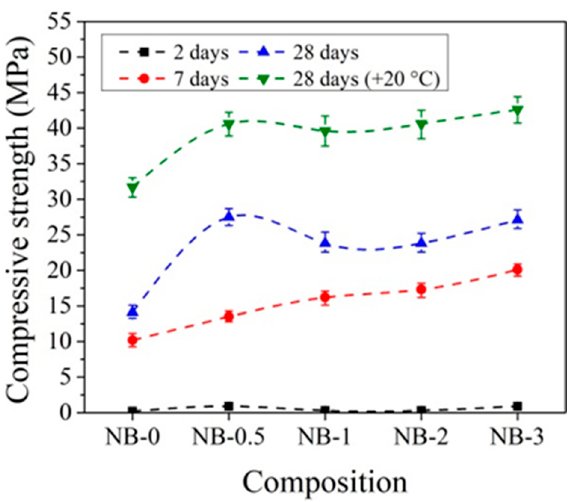
Figure 18. Compressive strength of concrete with CEM IIN samples at − 10 °C initial curing (28 days (+20 °C)—reference samples prepared and cured at +20 °C).